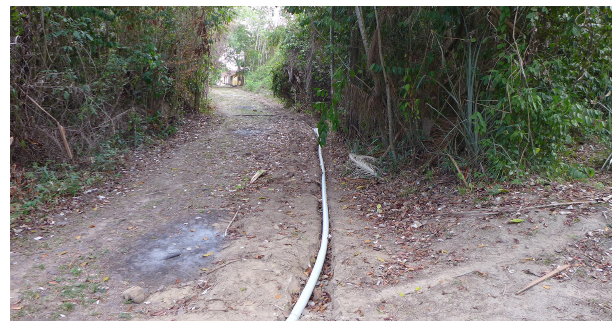
Figure 7. The plastic tube is shown that is used to protect the power supply and fibre optics cable running from the electronics house (visible at the far end in the image) to the variometer house (not